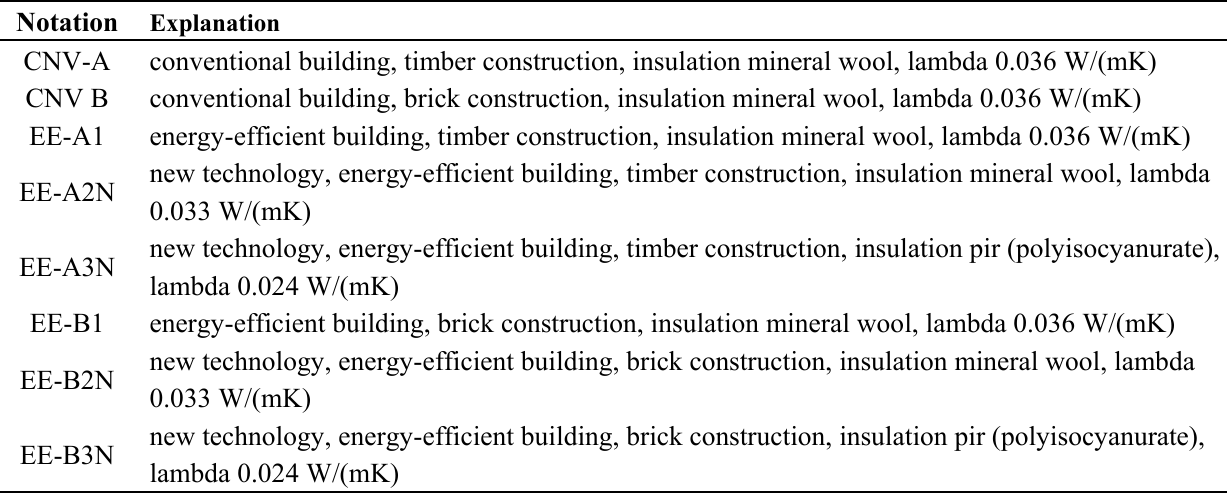
Table 1. Cases analyzed in this